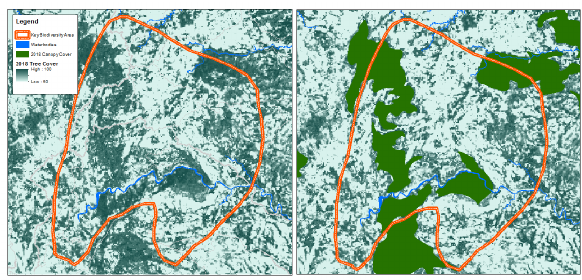
Figure 2. Map (A) shows the tree cover dataset used and Map (B) shows the extracted forest fragments